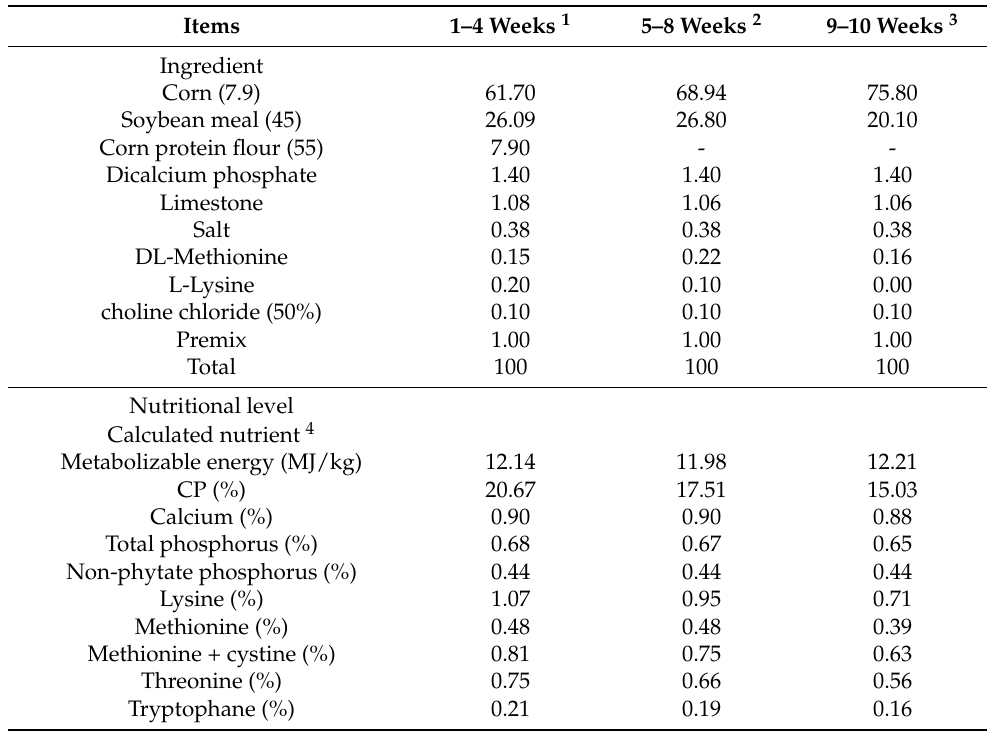
Table 2. Ingredient composition and nutrient content of the basal diet (%, as-fed basis).